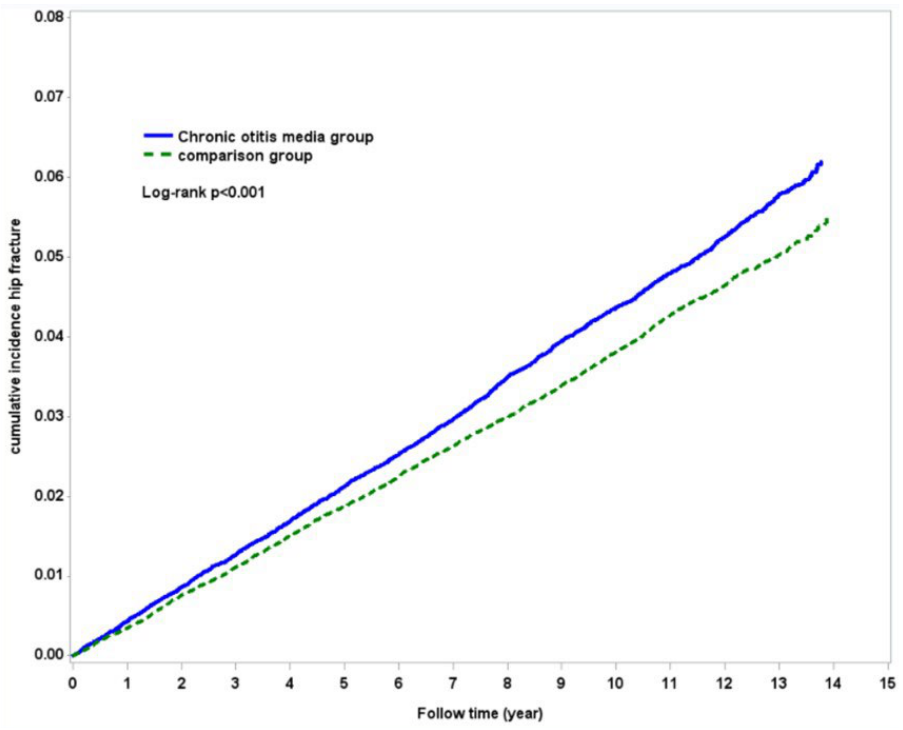
Figure 2. The incidence of hip fracture among COM and comparison cohorts. The dashed line indicates the comparison cohort, and the solid line indicates the COM cohort. Table 3 showed that the impact of COM and on the risk of hip fracture was more pronounced among subjects with female gender (aHR = 1.17; 95% CI = 1.09–1.26), hypertension (aHR = 1.14; 95% CI = 1.05–1.24), diabetes (aHR = 1.19; 95% CI = 1.07–1.32), ischemic heart disease (aHR = 1.15; 95% CI = 1.00–1.33), and chronic obstructive pulmonary disease